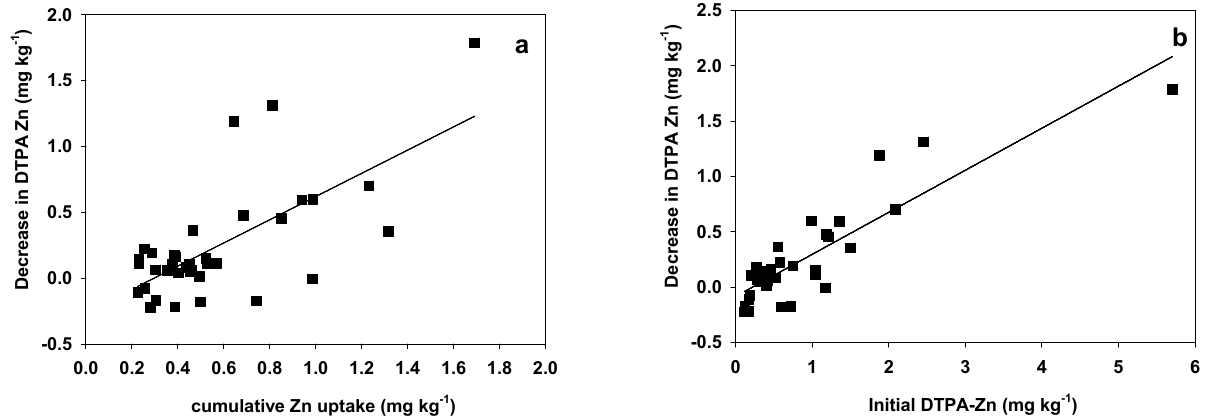
Figure 2. ( a ) Relationship between the decrease in DTPA extractable Zn (mg kg − 1 ) in soils and the cumulative Zn uptake by the four crops (expressed in mg kg − 1 of soil). Y = − 0.26 + 0.88 X; R 2 = 0.48; p < 0.0001. Regression for transformed variables to meet normality criteria is: Y − 0.35 = 0.71 − 0.65 Ln X; R 2 = 0.33; p < 0.001. ( b ) Relationship between the decrease in DTPA extractable Zn (mg kg − 1 ) and the initial DTPA extractable Zn in soils (mg kg − 1 ). Y = − 0.9 + 0.88 X; R 2 = 0.78; p < 0.0001. Regression for transformed variables to meet normality criteria is: Y − 0.35 = 1.07 − 0.18 Ln X; R 2 = 0.63; p <